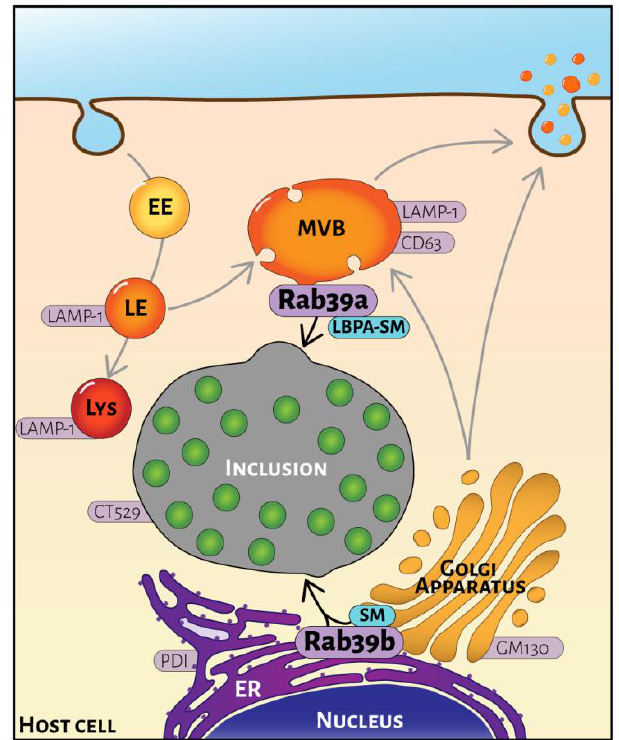
Figure 6. Scheme of Rab39a and Rab39b intracellular distribution in Chlamydia trachomatis -infected cell. Rab39a localizes at the late endocytic pathway mainly at multivesicular bodies (MBVs) labeled with CD63 and LAMP1. Rab39a transports sphingolipids (SM) and phospholipids (LBPA) from MBVs to the chlamydial inclusion. In contrast, Rab39b distributes at the early secretory route, particularly at the interface between the endoplasmic reticulum (ER) and the cis -Golgi. PDI labels the ER and GM130 identifies the Golgi apparatus. Rab39b controls the delivery to the chlamydial inclusion of newly synthesized sphingolipids (SM). EE, early endosomes; LE, late endosomes; Lys, Lysosomes.